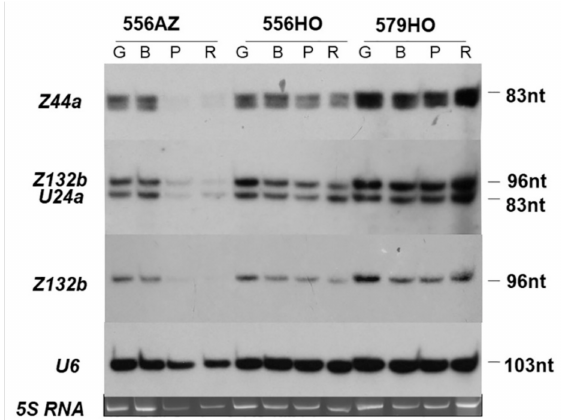
Figure3. ThesnoRNAtranscriptprofilesforazygous(556AZ)andhighSPD / SPMtransgenic(556HOand 579HO) tomatoes in green (G), breaker (B), pink (P), and red ripe (R–B + 8) fruit. Profiles of the U6 control and 5S RNA are shown at the